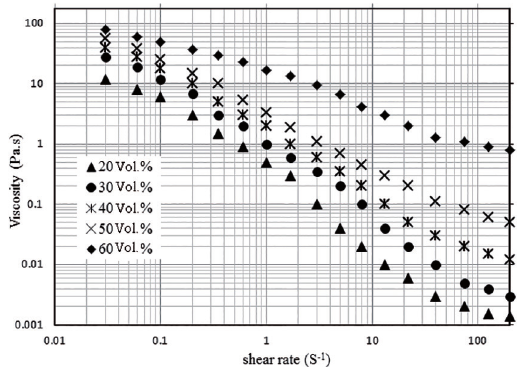
Figure 6: Variation of viscosity with the solid loading in the 0.4 wt. % TMAH dispersant at different shear rates.